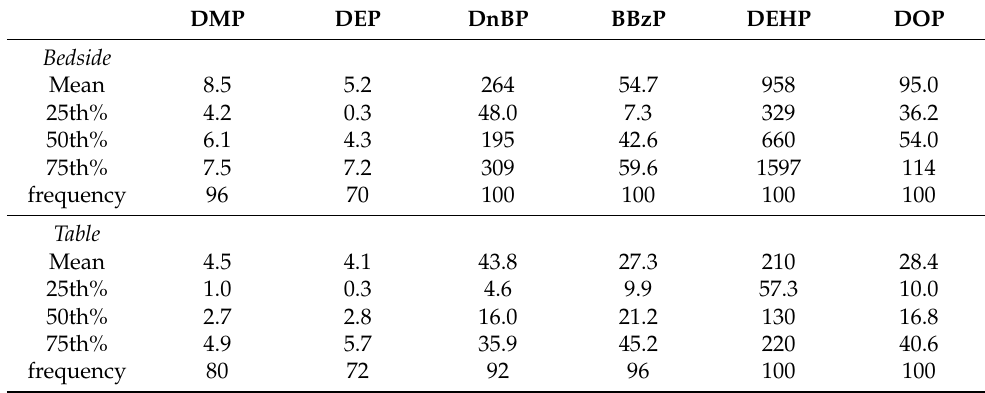
Table 1. Dust-phase phthalate concentrations in university dormitories ( µ g/g).